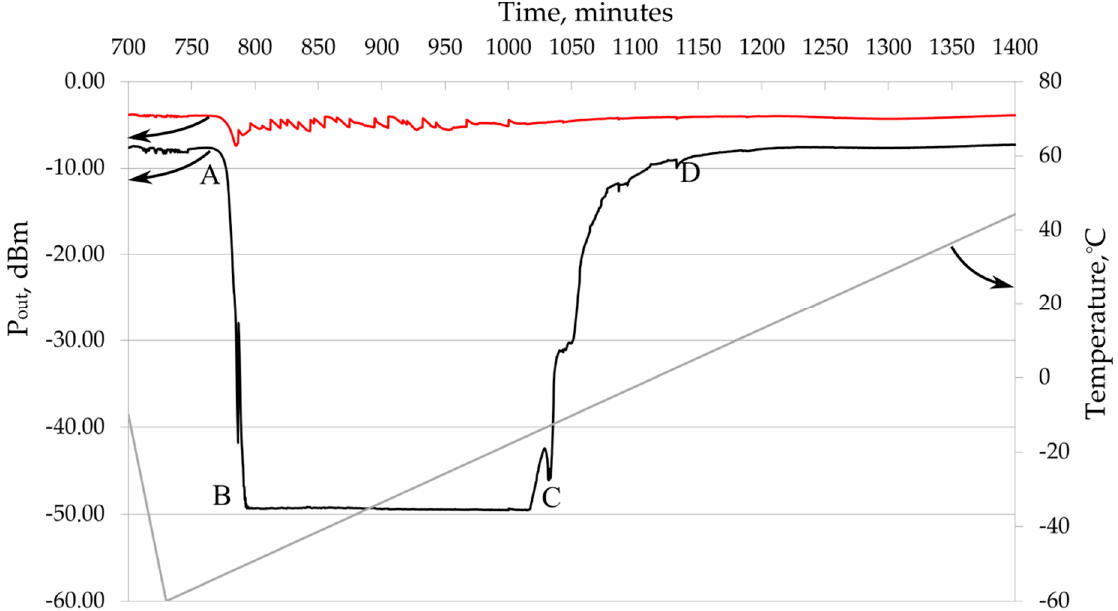
Figure 3. The change in the output signal of the Y-splitter under the action of the pyroelectric effect. Black and red lines are P out1 and P out2 respectively, gray line is temperature. The rate of temperature increase is 0.16 °C/min, the lowest sample temperature is about − 55 °C.